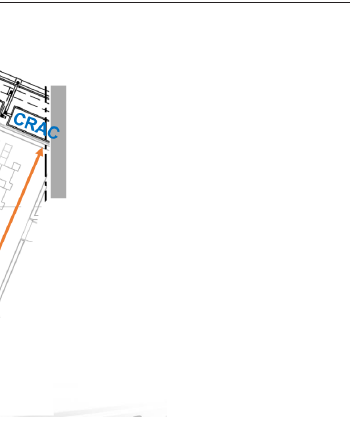
Figure 4. New Data Center - Network room floor